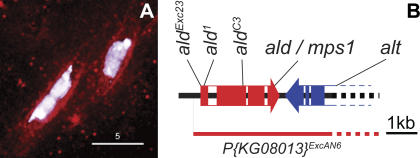

ald Mutants and Their Effects(A) An oocyte nucleus from a yw; aldC3/aldExc23; pol female, showing DNA (white) and tubulin (red). There is complete progression past metaphase I arrest, the chromosomes have separated into two masses, and each mass possesses its own individualized tubulin spindle.(B) A map of the ald locus showing the location of the mutants used in this paper. aldExc23: An incomplete excision of P{GS:13084} that leaves 130 nt from the 5′ end of the P element, inserted after the 14th nt of the 5′ UTR. This allele has good viability and fertility but high levels of NDJ and very low protein expression (see Figure 5B). ald1: A single nucleotide change causing a hypomorphic missense mutation (R7H). aldC3: A 9-codon deletion (Δ369–377) near the kinase active site, resulting in a semi-lethal allele similar to other ald null alleles. P{KG08013}ExcAN6 (also referred to as Df(3R)AN6): An imprecise excision of a P element that was inserted in the large intron of the next downstream gene to ald, CG18212/alt [44]. This excision retains 3782 nt of the 5′ end of the P sequence, then deletes approximately 8 kb of sequence (red bar), from the rest of the 3′ end of the P element to 165 nt upstream of the ald transcription start site; 98 nt of exon 2 of ald is present, reversed, at the excision site. This excision deletes all of the ald and alt protein coding sequences; alt mutants alone were previously shown to have no detectable effect on meiosis [5].